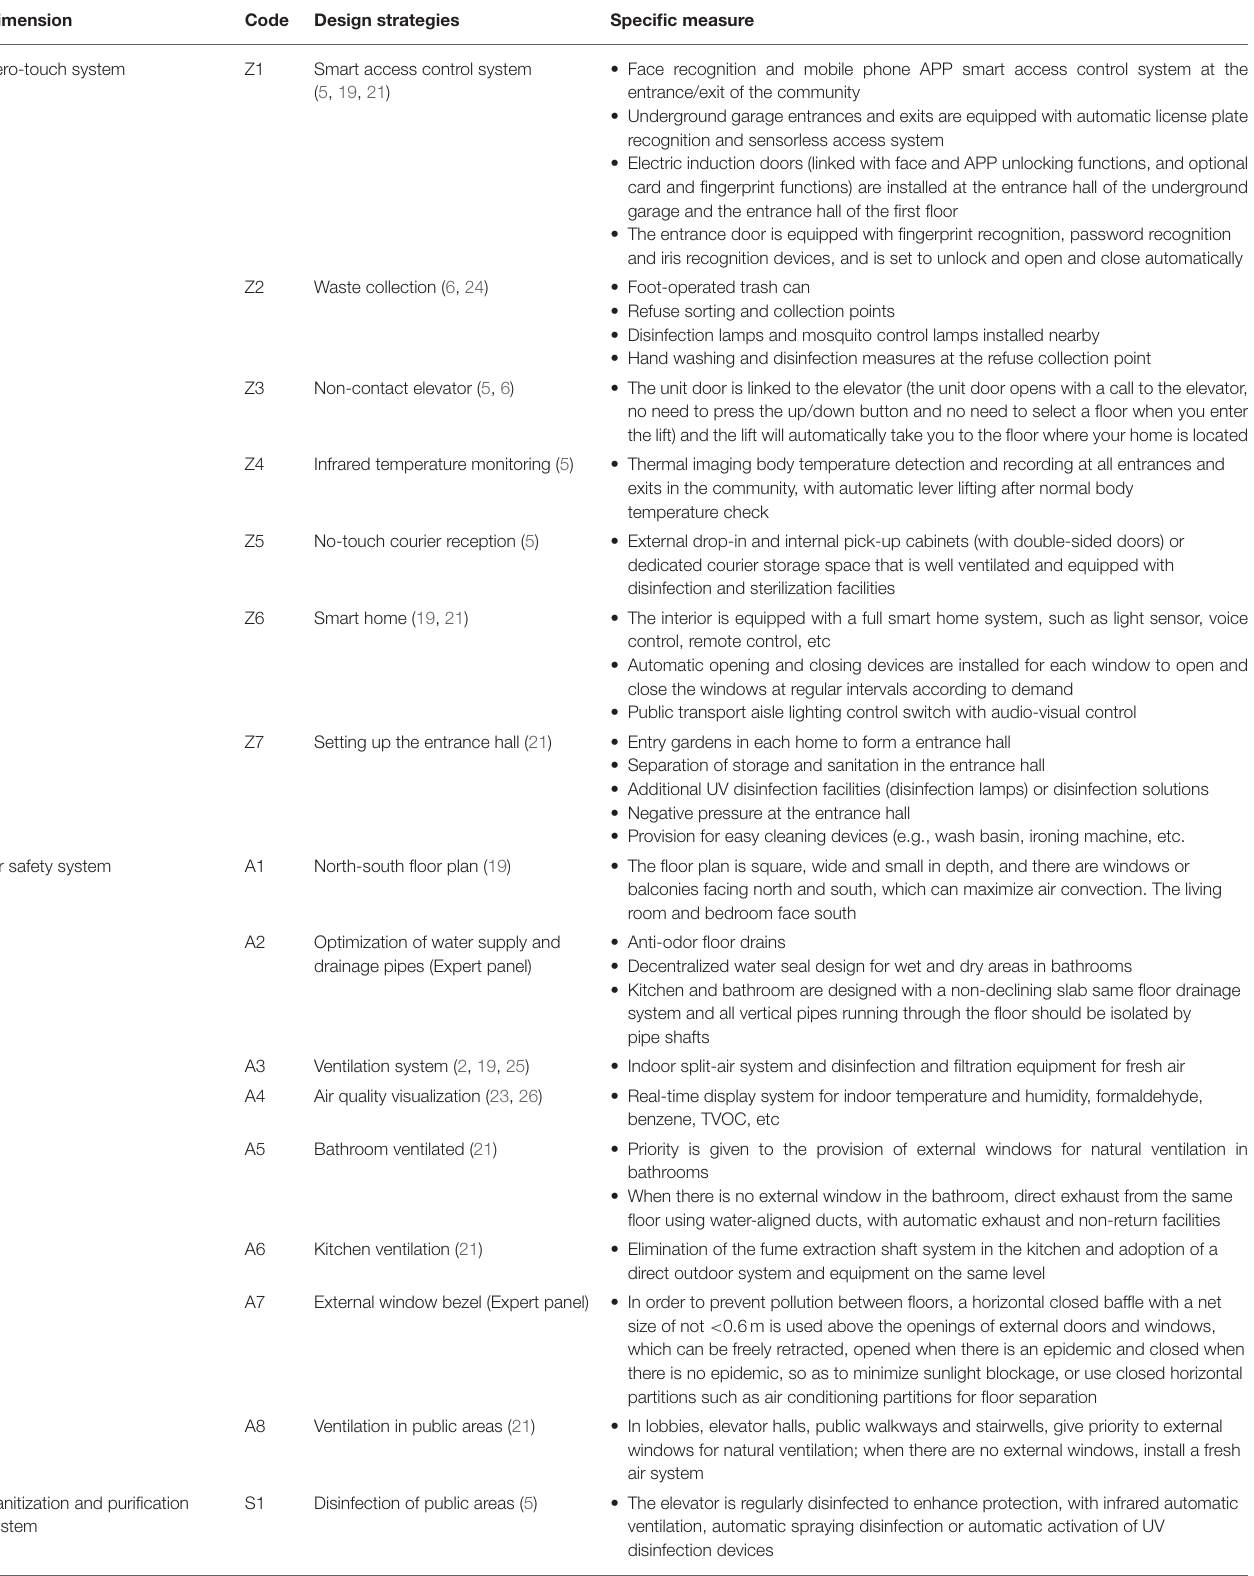
TABLE 1 | Design system of MURBs in the post-pandemic era.